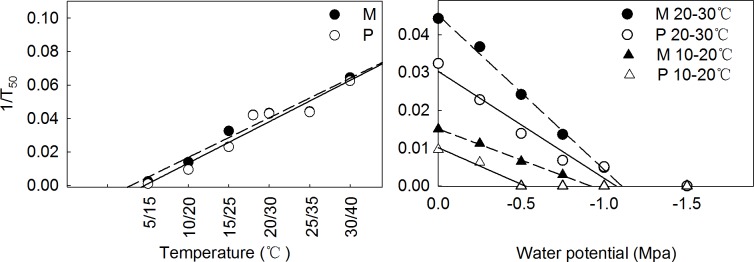
Linear relationship of temperature (calculated from average value of alternative temperature) and 1/T50 (left), water potential and 1/T50 (right) under 10/20°C, 20/30°C environment of M (solid dot) and P seed (hollow dot) of C. pauciflorus.Linear regression functions of temperature were y = -0.0185 + 0.0024x (R2 = 0.944) (M seed), y = -0.0235 + 0.0025x (R2 = 0.970) (P seed), respectively. Linear regression functions under different water potential were y = 0.0151 + 0.0164x (R2 = 0.999) (M seed at 10/20°C), y = 0.0101 + 0.0193x (R2 = 0.986) (P seed at 10/20°C), and under 20/30°C were y = 0.0451 + 0.0408x (R2 = 0.997) (M seed at 20/30°C), y = 0.0303 + 0.0282x (R2 = 0.976) (P seed at 20/30°C), respectively. Germination rate (y) calculated as the inverse of T50, that is, the number of days necessary to reach 50% of the final germination proportion.